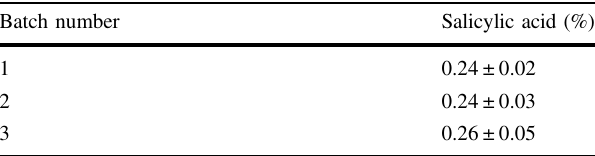
Table 11 The content of salicylic acid in compound enteric-coated